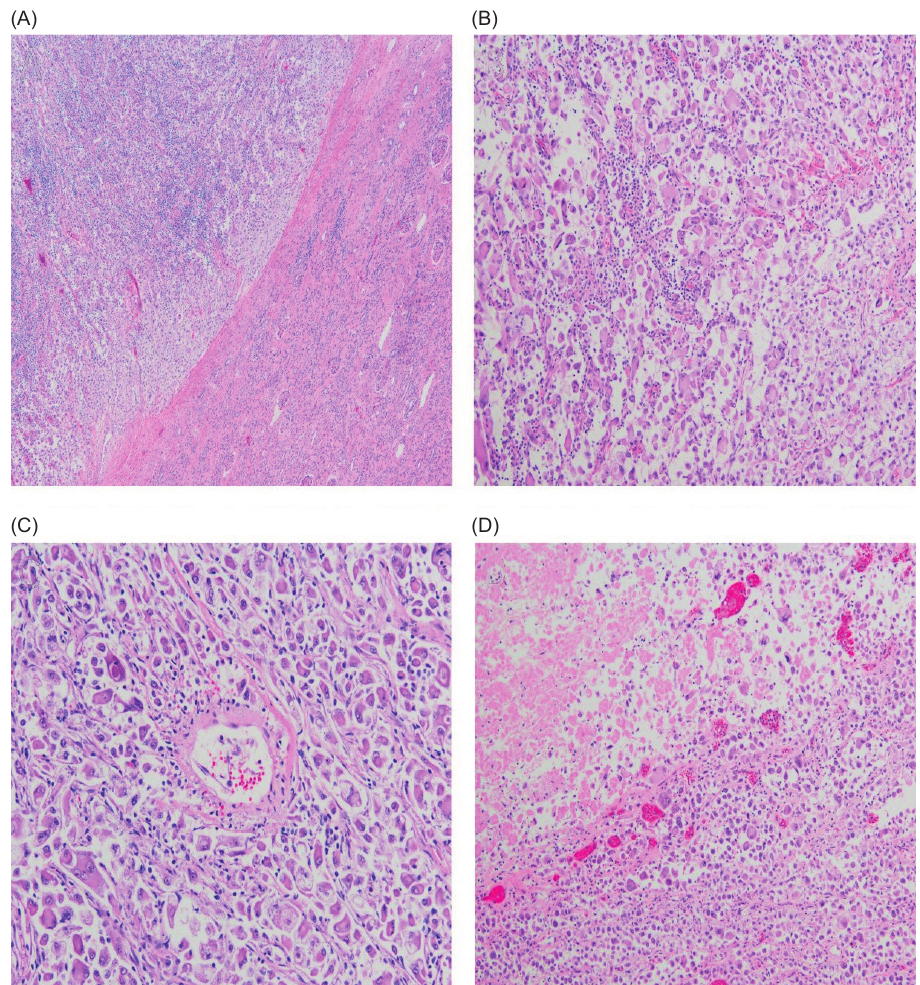
Figure 2: Primary tumor histology. Under low magnification (×40), the lesion can be seen arising in the kidney (A). Under higher magnification (×100), the lesion is composed of pleomorphic eosinophilic cells with prominent nucleoli (B), with some tumor cells intimately associated with vessels (C), and extensive necrosis